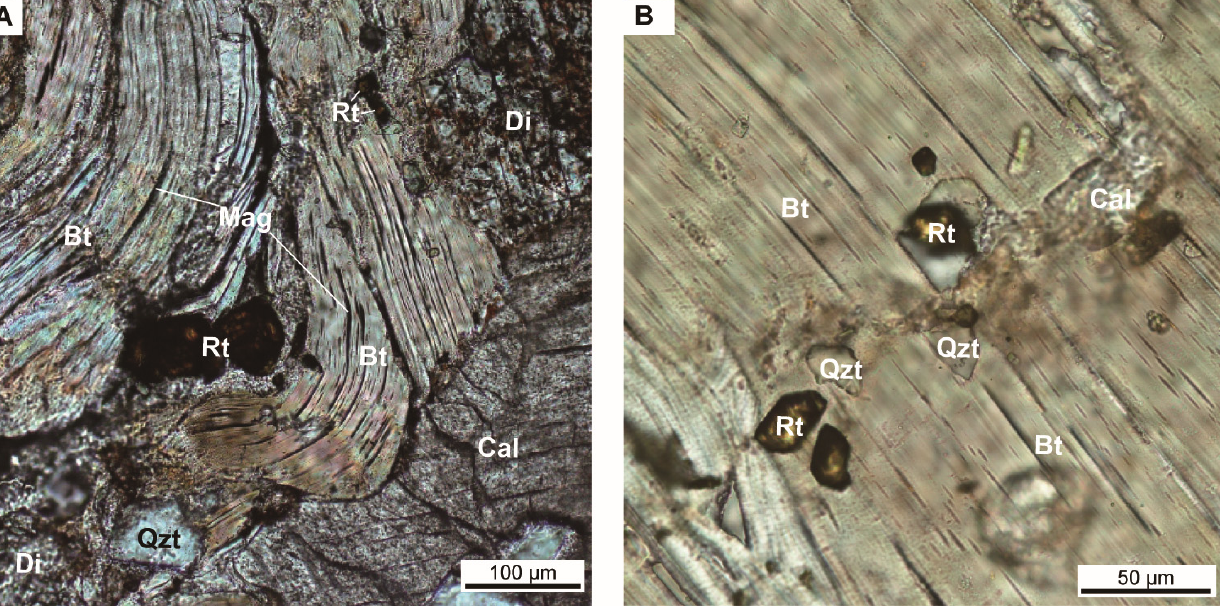
Figure 3. Representative photomicrographs under plane-polarized light. ( A ) Dense rutile clusters along the curved foliation formed predominantly by biotite; ( B ) isolated rutile grain in biotite. Abbreviations: Bt = biotite, Cal = calcite, Di = diopside, Mag = magnetite, Qzt = quartz, Rt = rutile.